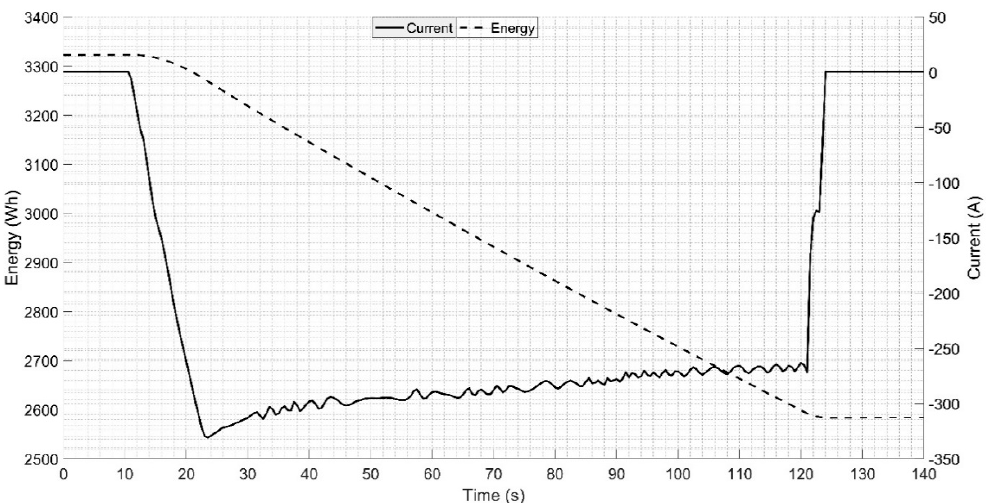
Figure 7. Battery energy and current trends during charging.